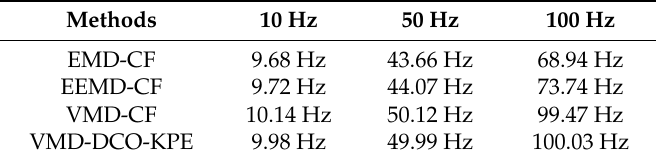
Table 7. Frequency features by different frequency feature extraction methods.